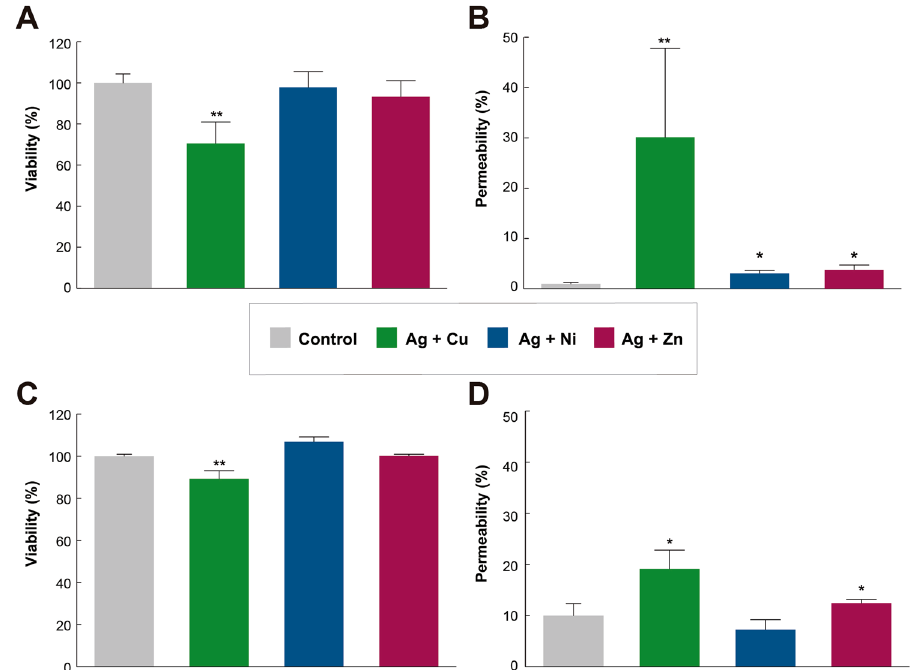
Figure 6. Viability and cell permeability assay of B. subtilis and E. coli treated with STMCs. Nominal concentrations of Ag/Cu Ag/Ni and Ag/Zn (15 μ M/0.5 mM) by 24 h (37 °C). ( A ) SyBR-G B. subtilis positive cells represented as a measure of % of viability; whereas ( B ) B. subtilis PI positive cells are represented as a measure of % of permeability. ( C ) SyBR-G E. coli positive cells represented as a measure of % of viability; whereas ( D ) E. coli PI positive cells are represented as a measure of % of permeability Values represent mean ± SD (n = 3 experiments for each treatment). P values * P < 0.05 vs. Control, ** P < 0.01 vs.